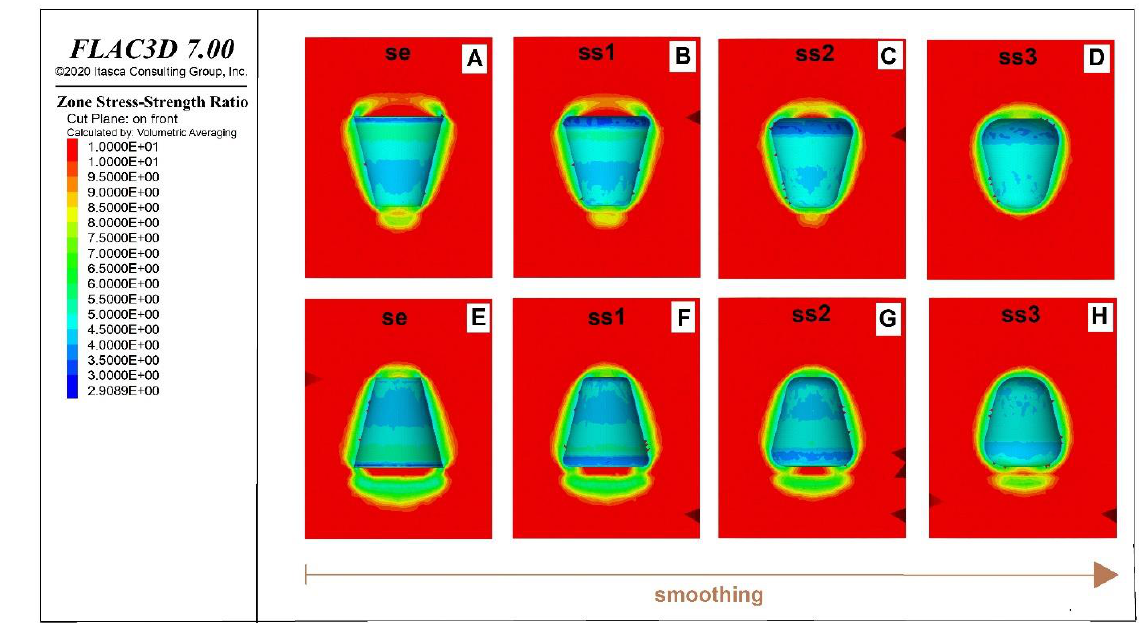
Figure 14. The strength/stress ratio (SSR) in the caverns with maximum initial diameter of 120 m; the initial state ( A – H ).